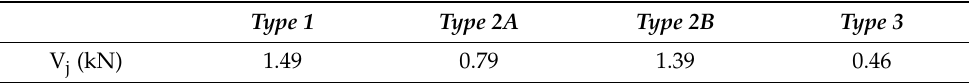
Table 10. Model A (with semi-rigid connections). Maximum residual shear forces in the joints.